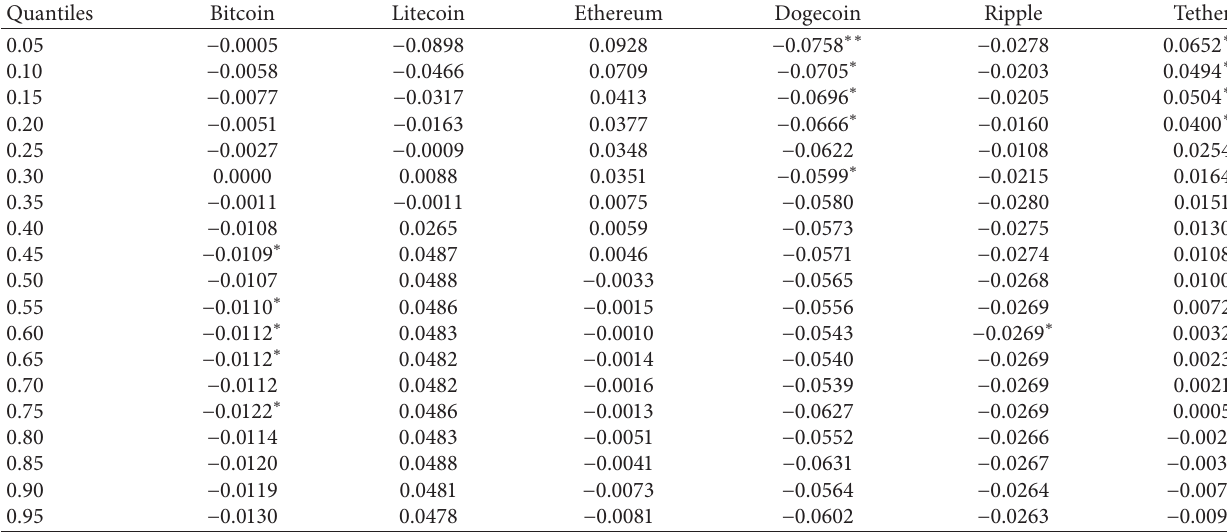
Table 5: Quantile regression results of